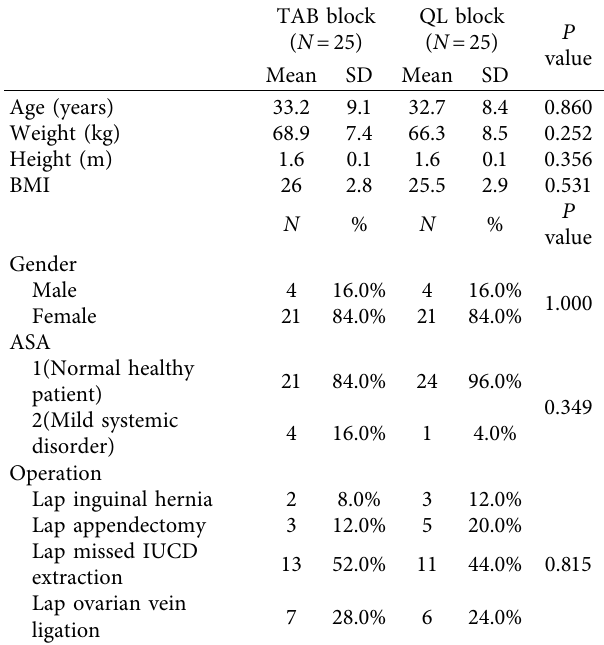
Table 1: The patient’s characteristics and operative